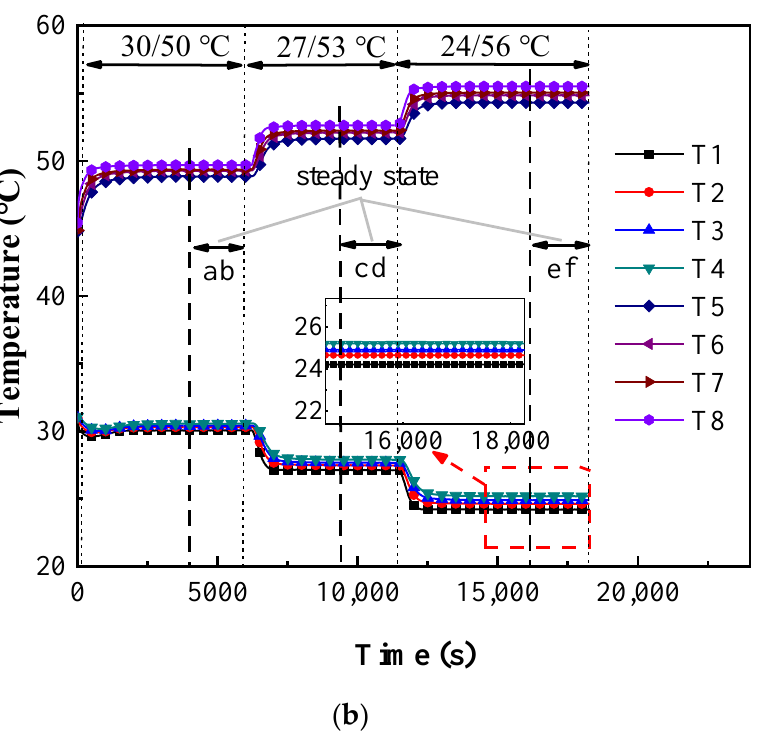
Figure 7. The experimental results of deionized water with the qualitative temperature of 40 °C as the example. ( a ) h = 30 mm and ( b ) h = 45 mm.